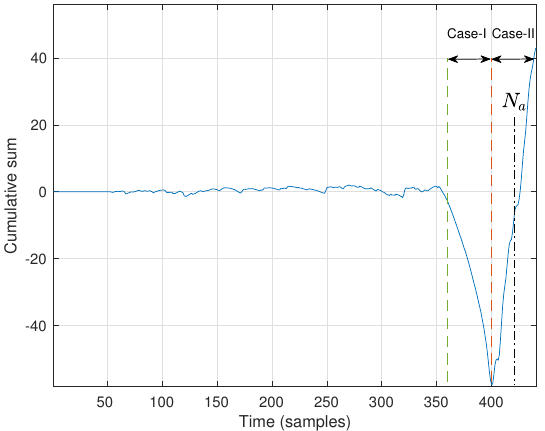
Figure 5. Cumulative sum of log-likelihood